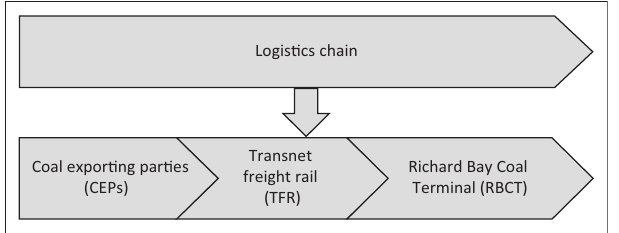
FIGURE 2: The bulk coal export logistic chain.